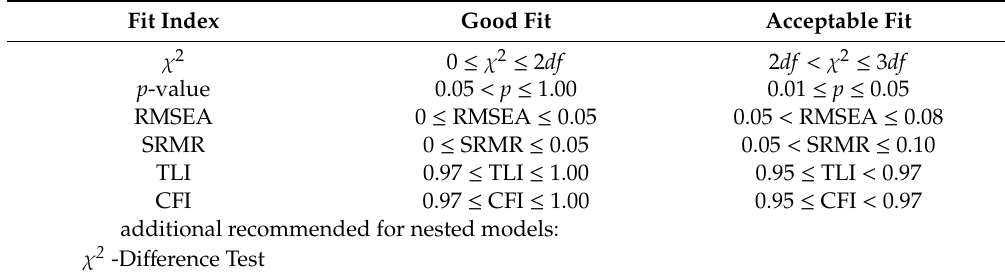
Table 3. Recommendation for fit indices.